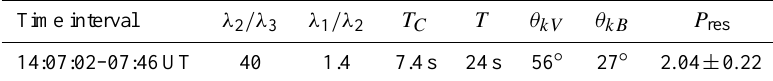
Table 2. Properties of the waves. Time interval λ 2 /λ